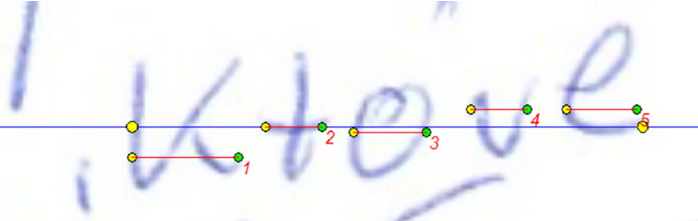
Fig 2. The example of examination with the use of Raygraf software. Estimation of the total width of the specimen (a line between extreme yellow points) and widths of the morphemes of a word (lines no 1, 2, 3, 4, 5).